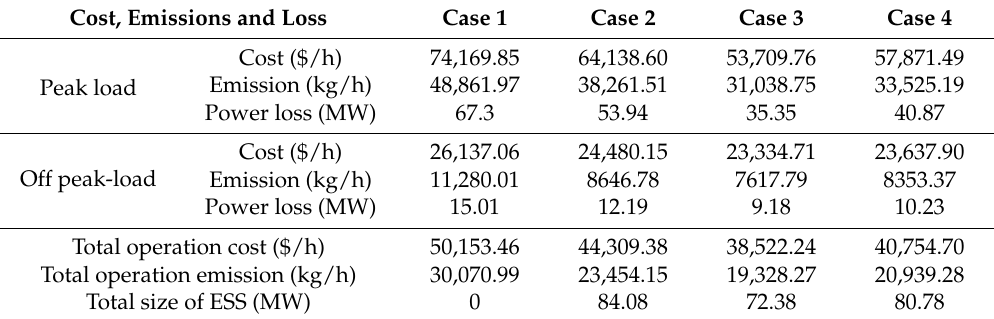
Table 5. Expected value in four cases.